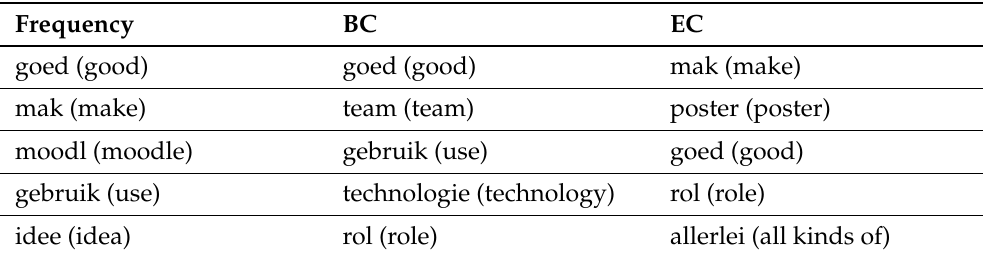
Table 6. Top 5 words with frequency-wise ordering, betweenness centrality (BC)-wise ordering and eigenvector centrality (EC)-wise ordering in the red phase in decreasing order. The English translation of the Dutch processed words is in the